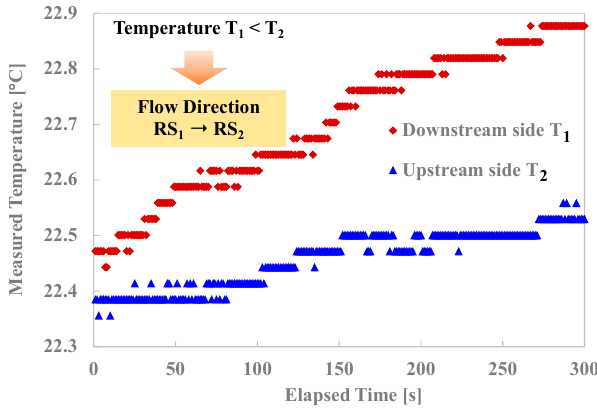
Figure 9. Results of the flow direction